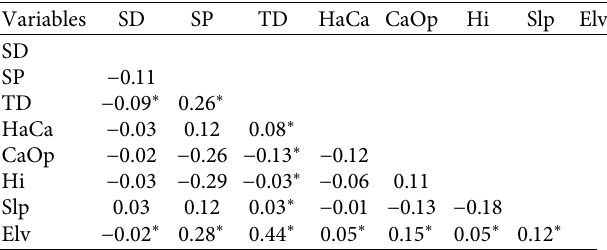
Table 16: Comparisons of tree densities with DBH 10–20cm (a) and DBH > 20cm (b) of MFBR with eleven other moist Afro- montane forests in southwestern